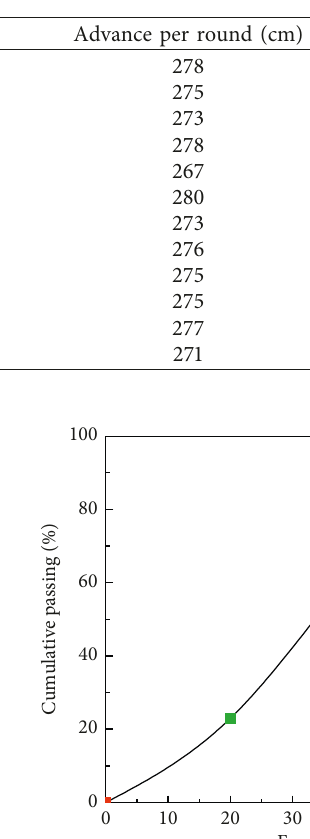
Table 3: Statistics of cut holes.